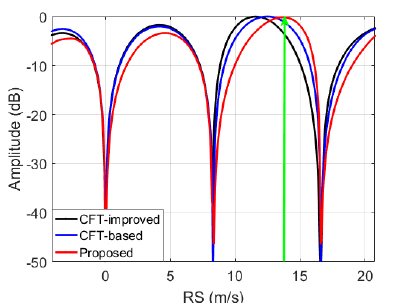
Figure 14. The beamformer of clutter suppression for different